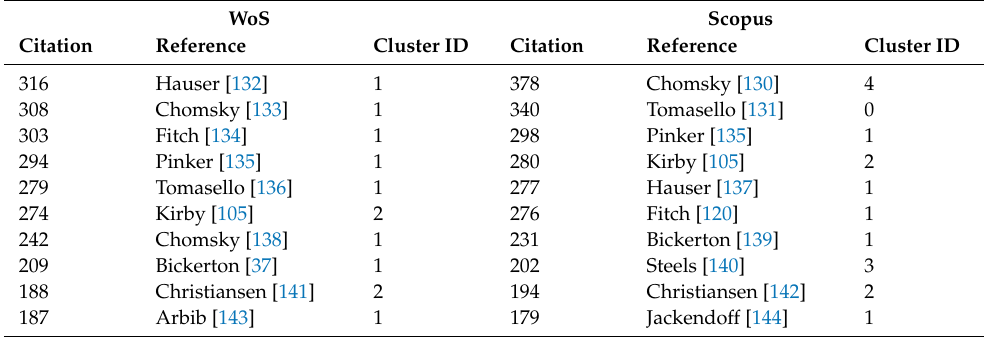
Table 5. Citation counts of biolinguistics by references using scientometric